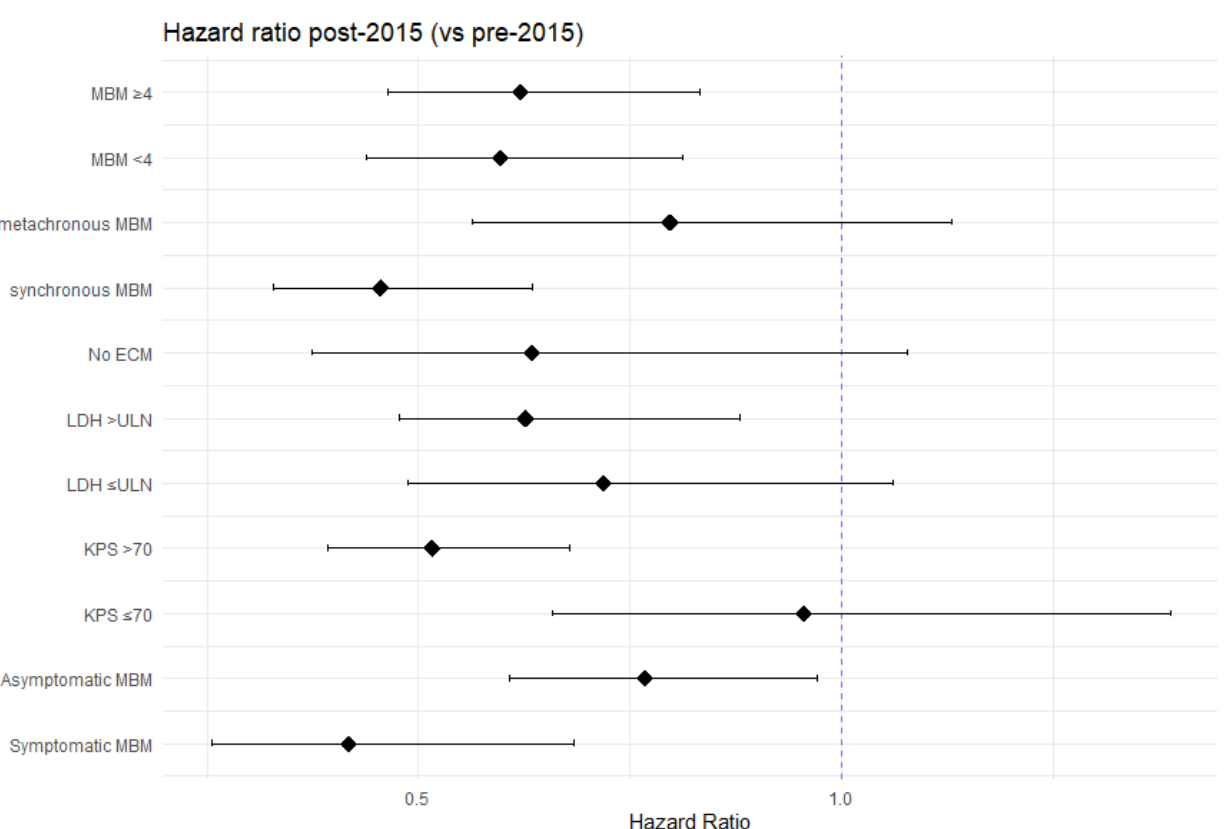
Figure 2. Forrest plot reflecting the hazard ratios (with 95% confidence interval) for patients diag- nosed with melanoma brain metastasis (MBM) post-2015 (versus pre-2015) in several subgroups. Abbreviations: LDH: lactate dehydrogenase, ULN: upper limit of normal (247 U/L), KPS: Karnofsky performance status.